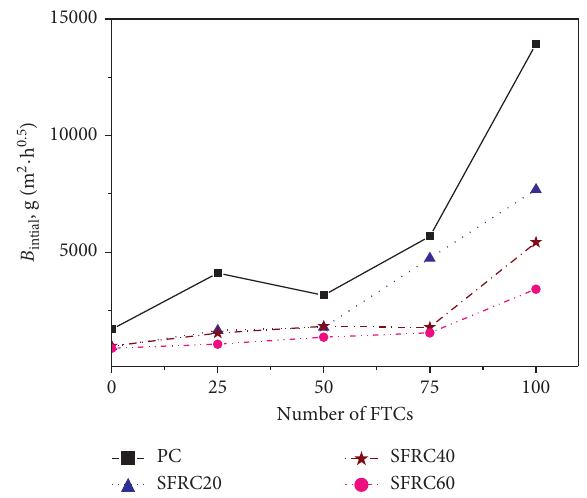
Figure 8: FTCs influence on initial coefficient of